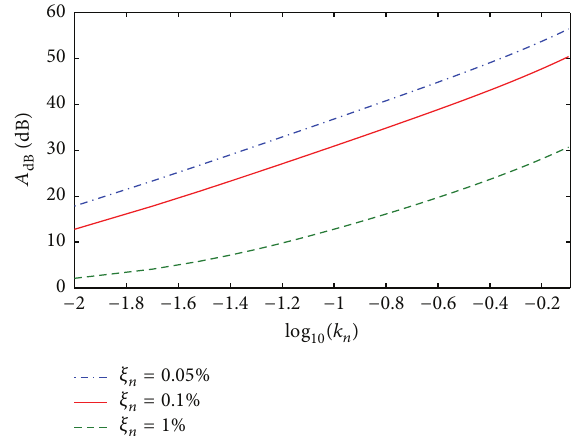
Figure 4: Relationship between 𝐴 dB and log 10 𝑘 𝑛 for different systems (i.e., different 𝜉 𝑛